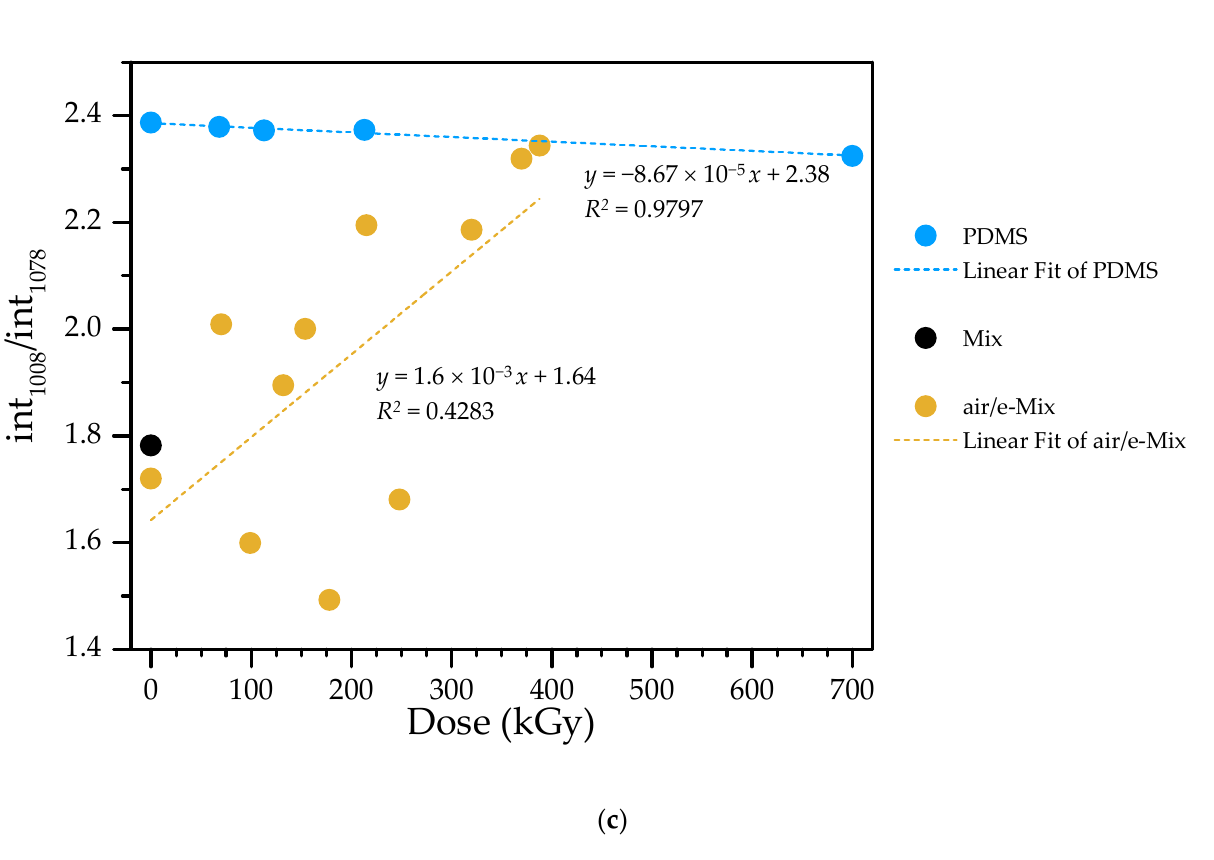
Figure 7. ( a , b ) FTIR spectra and ( c ) intensities ratio of bands at 1008 cm −1 and 1078 cm −1 . As reported by Kongwudthiti et al. [50], infrared vibrations of Si—O—Zr bonds may go from 965 cm −1 to as far as 1025 cm −1 , in mixed oxides of silica-modified zirconia, depending on the concentration of Si and Zr.